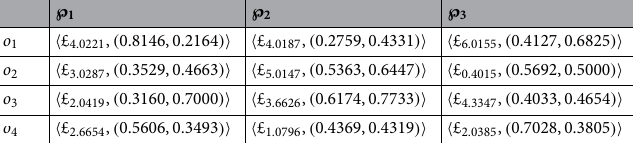
Table 11. WHM Collective decision matrix.